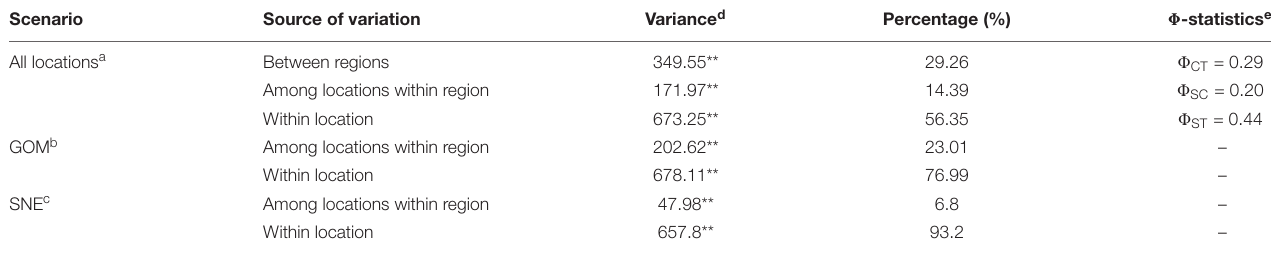
TABLE 2 | Analysis of molecular variance for sugar kelp in Northwest Atlantic using genome-wide single nucleotide polymorphisms data. Scenario